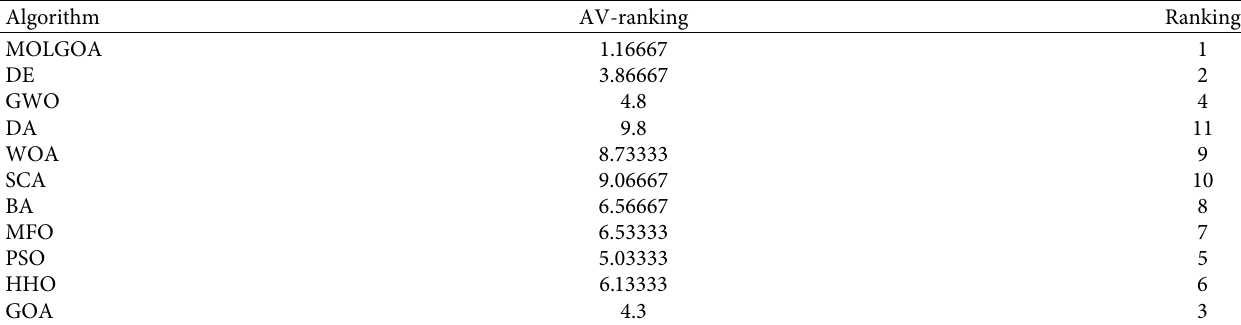
Table 8: Average ranking values of the Friedman